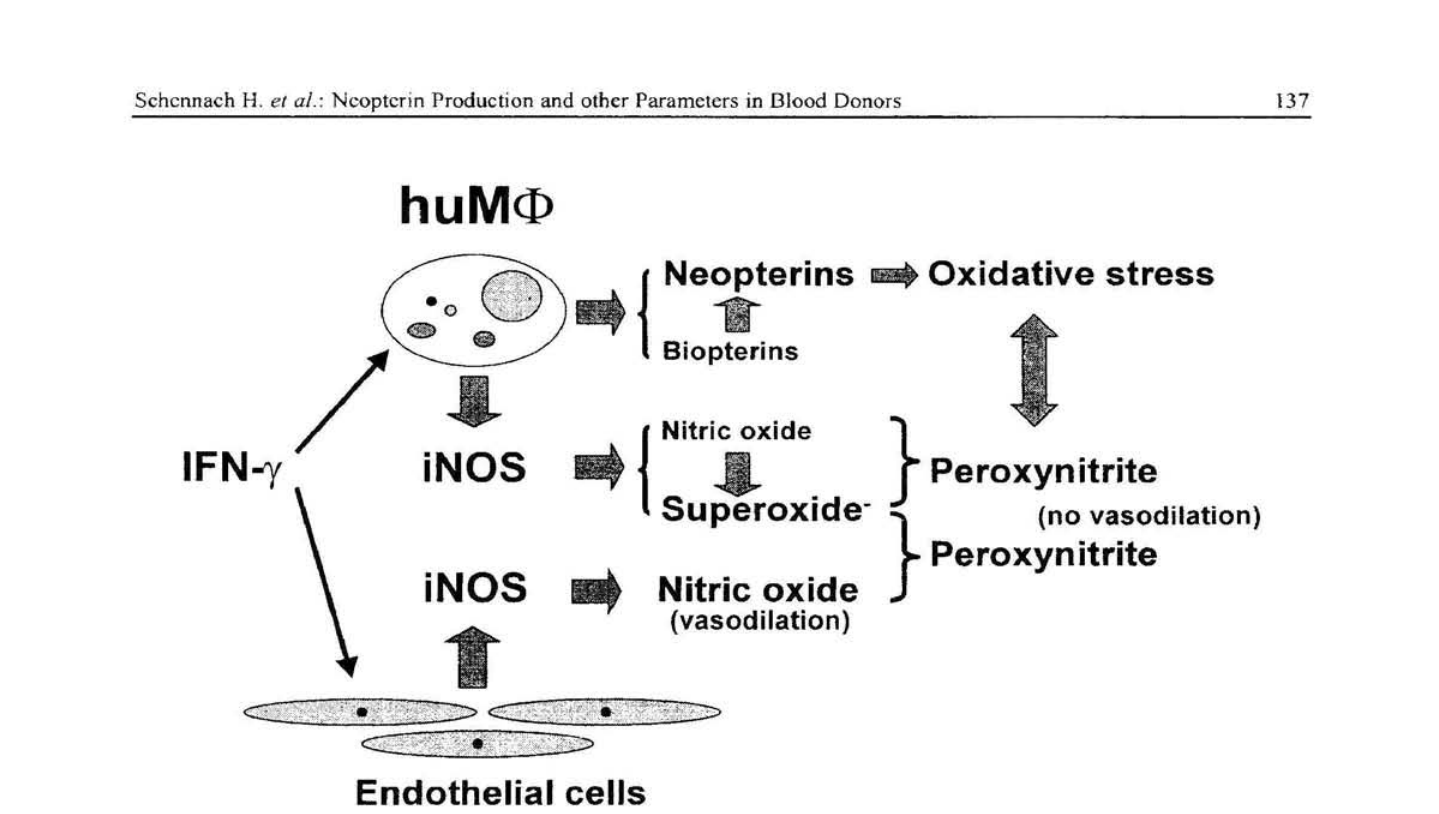
Figure 4. Proposed interaction between increased neopterin production and diminished av ailability of nitric oxide in humans during states of immune activation: Interferon-γ (IFN-γ) released by T-cells stimulates monocyte-de- rived macrophages (MF) for the expression of nitric oxide synthase (iNOS) and formation of pteridines. In human cells, large amounts of neopterins (neopterin and 7,8-dihydroneopterin) are produced at the expense of biopterins {mainly 5,6,7,8-tetrahydrobiopterin, H4bip). Oxidative stress is developing and will further diminish availability ofH4bip. Due to the deficiency of H4bip, no nitric oxide is produced but reactive oxygen species like superoxi- de anion are released by monocyte-derived macrophages. Moreover, superoxide anion reacts with nitric oxide, e.g. released from endothelial cells to form peroxynitrite thereby destroying the vasodilatory effect of nitric oxide.